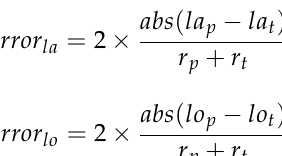
Figure 8. The four different types of data sets in the experiment.